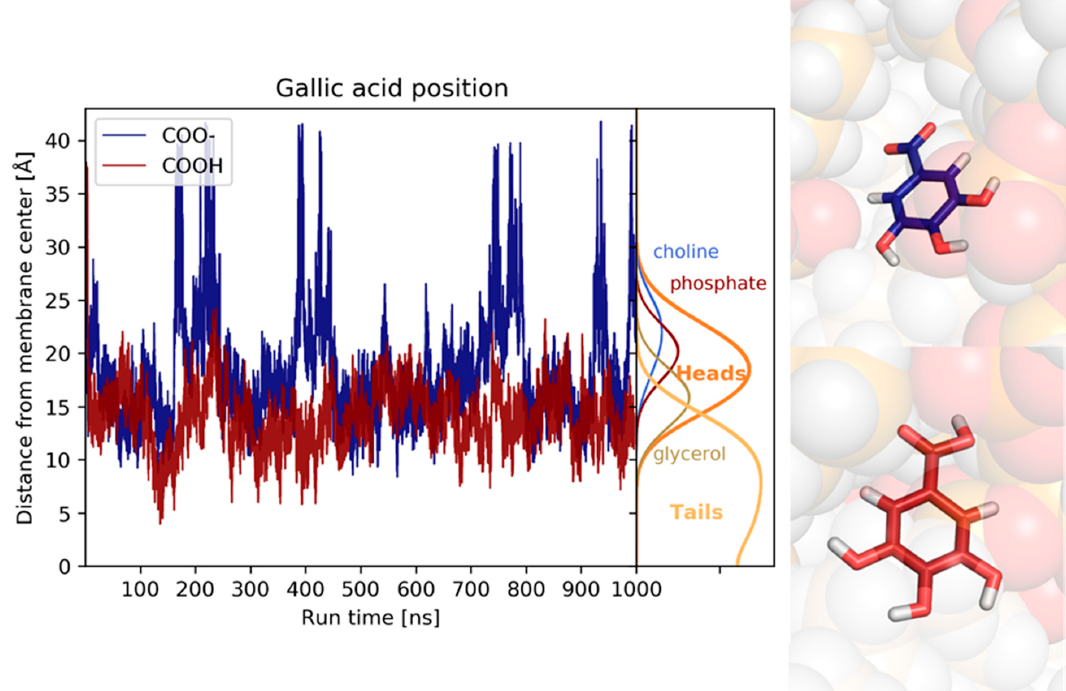
Figure 14. The z-coordinate of the center of mass of the protonated (red) and deprotonated (blue) gallic acid.